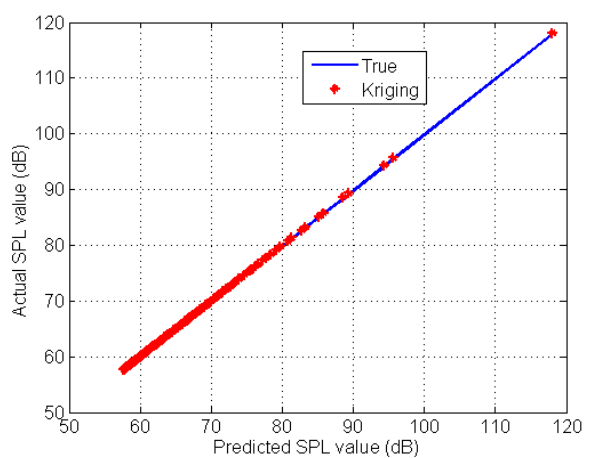
Figure 8. Cross-validation results of Kriging for maximum SPL with 30 LHS